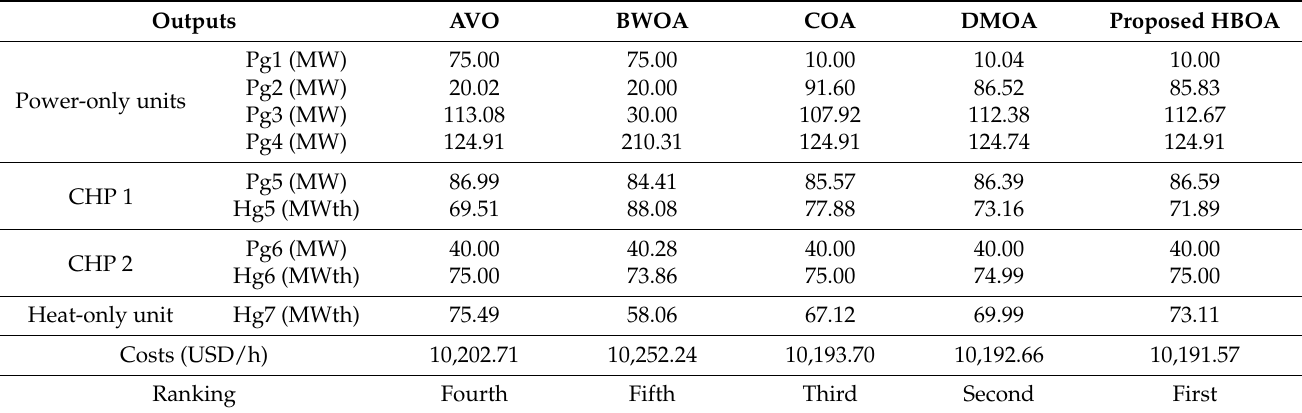
Table 5. Results of the proposed HBOA and the AVO, DMOA, COA, and BWOA of Case 1 for the third loading level.